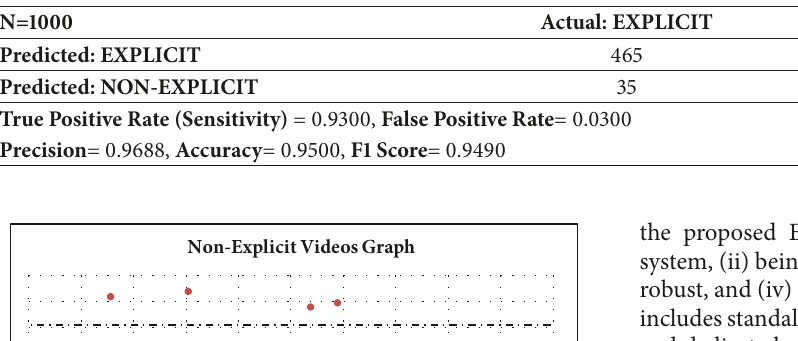
Table 5: Confusion matrix for video dataset.